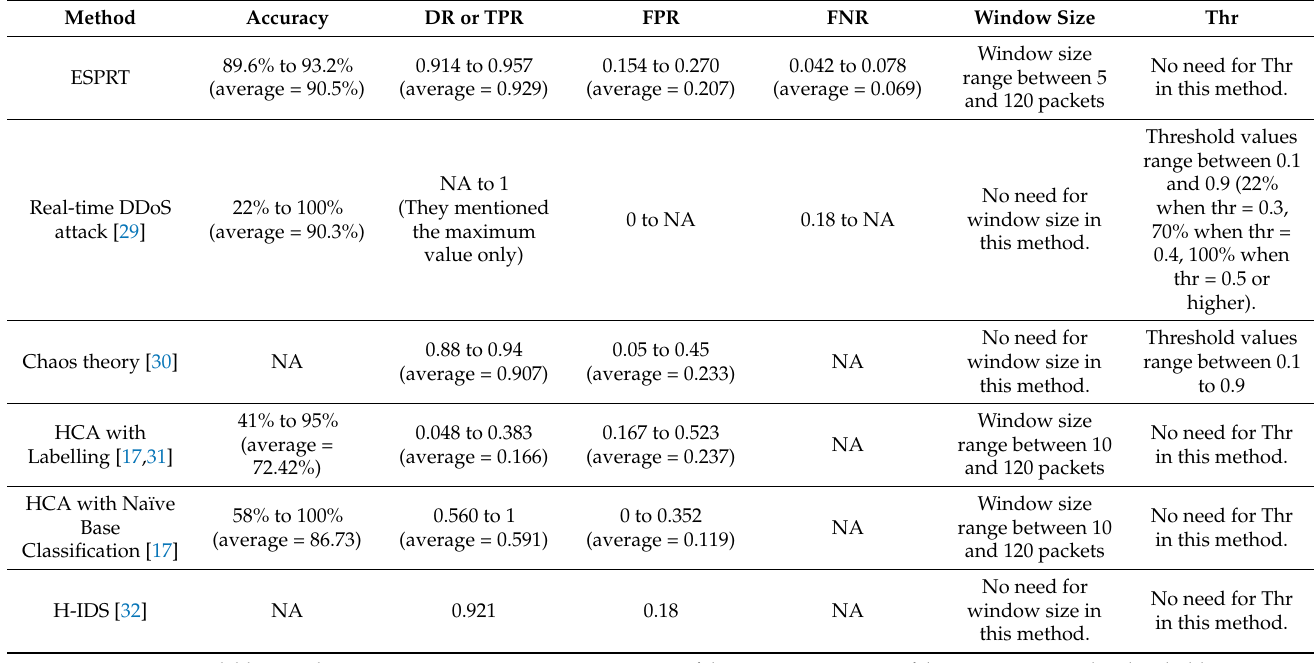
Figure 7. Specificity vs. fall-out for different detection methods for the Friday_1998 dataset. Table 3. Comparison with other approaches based on the DARPA 2000